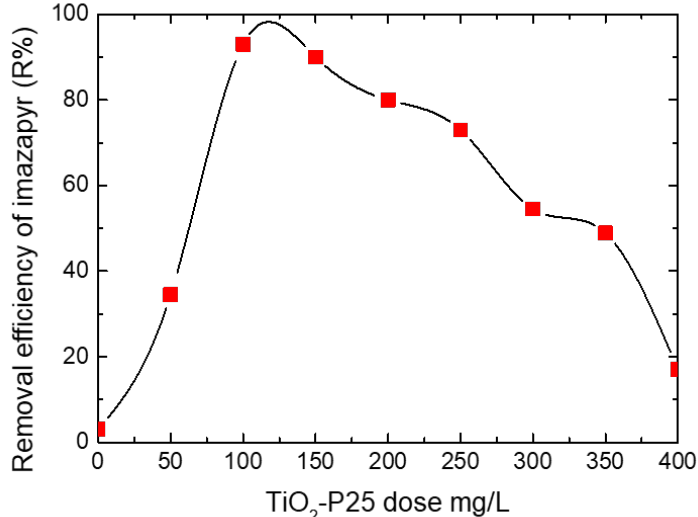
Figure 5. Removal efficiency of imazapyr under variation of TiO 2 concentration. C (Imazapyr) = 5 μΜ , stirring speed = 1000 min −1 , aqueous suspension Milli-Q water.